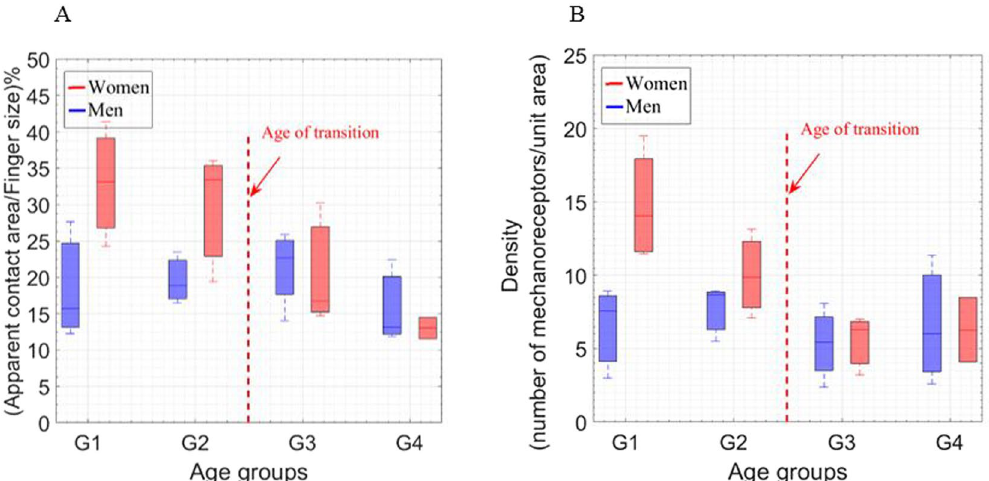
Figure 8. ( A ) Ratio of apparent contact area over finger size. ( B ) Density of real contact areas as a function of age and gender, via the captured video. The four age groups (G1, G2, G3, and G4) correspond to (26 ± 3, 35 ± 3, 45 ± 2, and 58 ± 6 years old), respectively, for men and women. Pearson’s statistical analyses: ( + for r > 0.8, − for r < − 0.8) highly correlated, (0) for no correlation, R indicates the correlation results, * p < 0.05 for statistically significant. The statistics analysis shows significantly larger finger size for women for G1 and G2 age groups (p < 0.05). Then, the density results are almost the same for men and